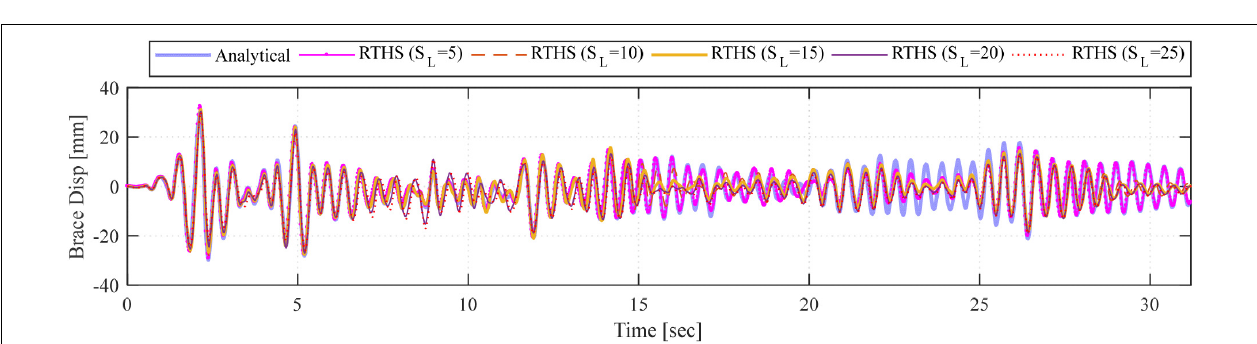
FIGURE 18 | Comparison of brace displacements from online RTHS tests with using ATS compensator (for different geometric scales) against pure analytical